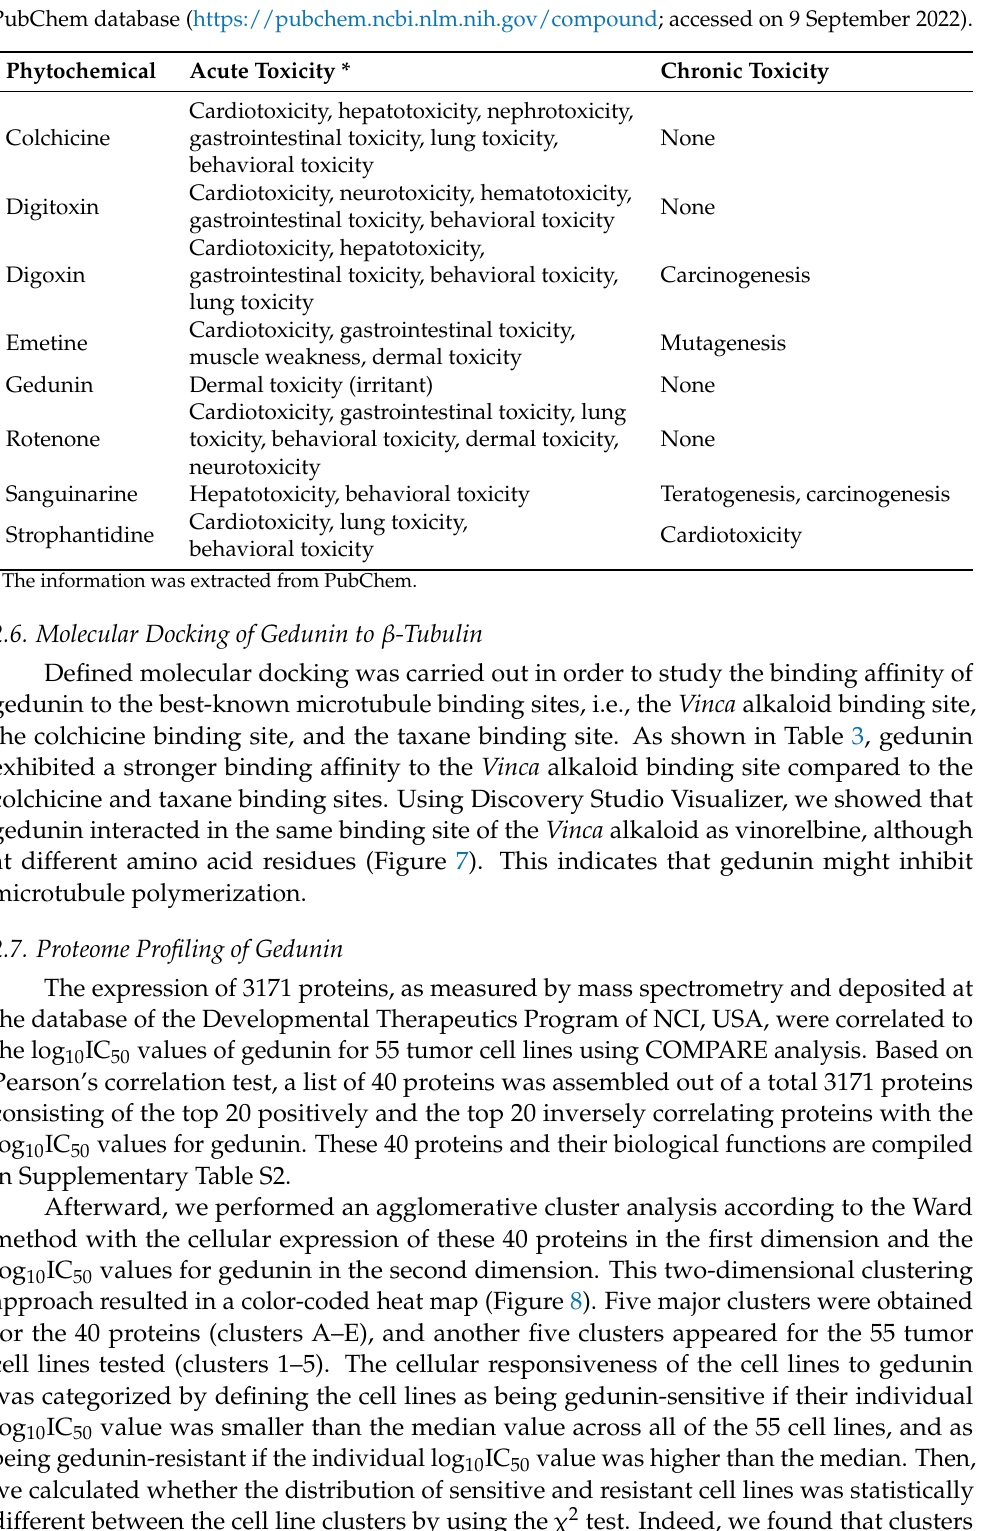
Table 2. Acute and chronic toxicity of selected phytochemicals. The data were mined from the PubChem database (https://pubchem.ncbi.nlm.nih.gov/compound; accessed on 9 September 2022). Phytochemical Acute Toxicity * Chronic Toxicity Cardiotoxicity, hepatotoxicity, nephrotoxicity, Colchicine gastrointestinal toxicity, lung toxicity, behavioral toxicity Cardiotoxicity, neurotoxicity, hematotoxicity, Digitoxin gastrointestinal toxicity, behavioral toxicity Cardiotoxicity, hepatotoxicity, Digoxin gastrointestinal toxicity, behavioral toxicity, lung toxicity Cardiotoxicity, gastrointestinal toxicity, Emetine muscle weakness, dermal toxicity Gedunin Dermal toxicity (irritant) None Cardiotoxicity, gastrointestinal toxicity, lung Rotenone toxicity, behavioral toxicity, dermal toxicity, neurotoxicity Sanguinarine Hepatotoxicity, behavioral toxicity Teratogenesis, carcinogenesis Cardiotoxicity, lung toxicity, Strophantidine behavioral toxicity